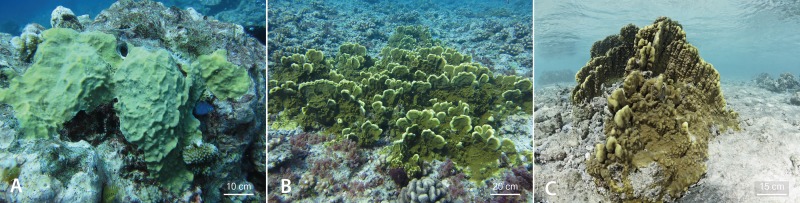
Morphologies of Millepora platyphylla colonies in habitats experiencing contrasting hydrodynamic regimes.(A) Encrusting wave-tolerant morphology in the mid slope, a fore reef habitat at 13 m; (B) sheet tree morphology vulnerable to wave-induced breakage in the upper slope, a fore reef habitat at 6 m and (C) massive wave-tolerant morphology in the patch reef, a lagoonal habitat (photo is courtesy of Gilles Siu).